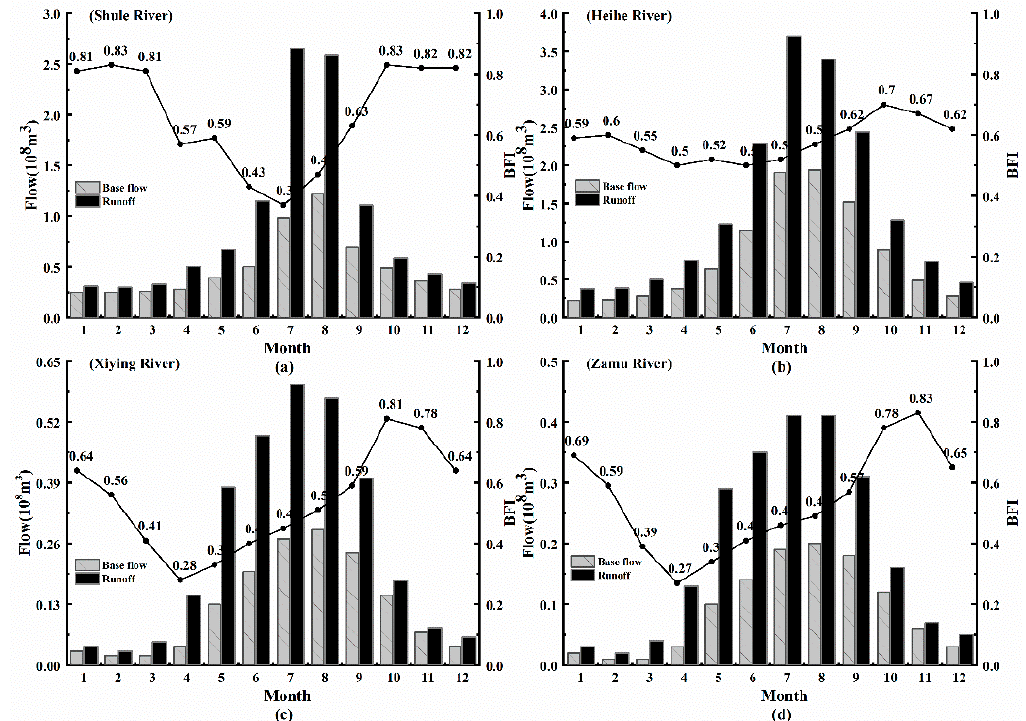
Figure 3. The trend of the intra-annual base flow, runoff, and BFI (Base Flow Index) values of the in Hexi inland rivers basin: ( a ) the Shule River; ( b ) the Heihe River; ( c ) the Xiying River; and ( d ) the Zamu River.